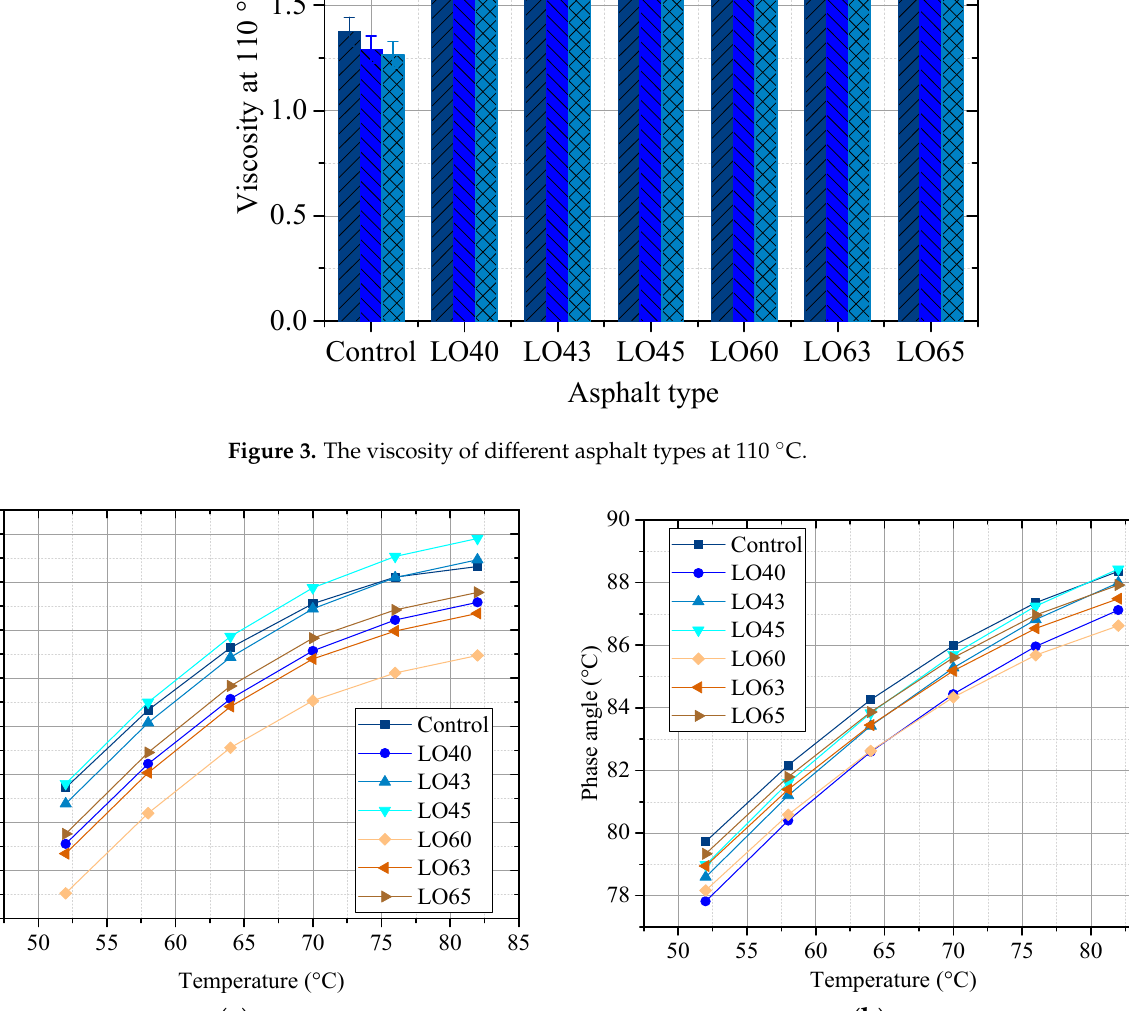
Figure 4. Phase angle of the unaged and the RTFO-aged asphalt binders. ( a ) The unaged; ( b ) The RTFO-aged.